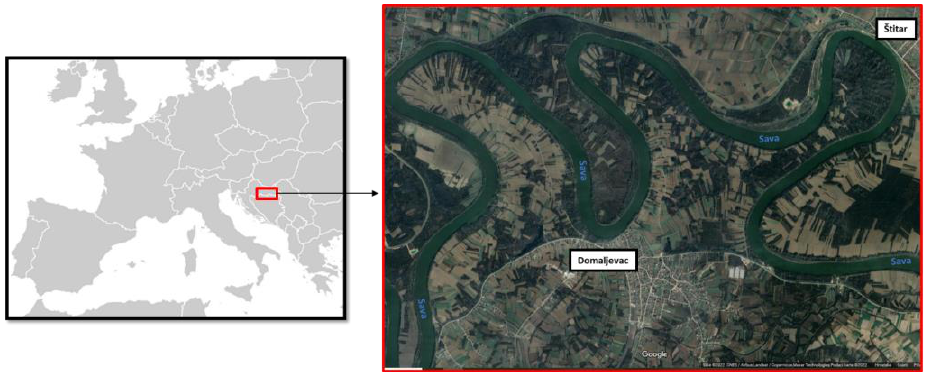
Figure 1. Locations of the origin of the samples (Wikimedia Commons 2020).